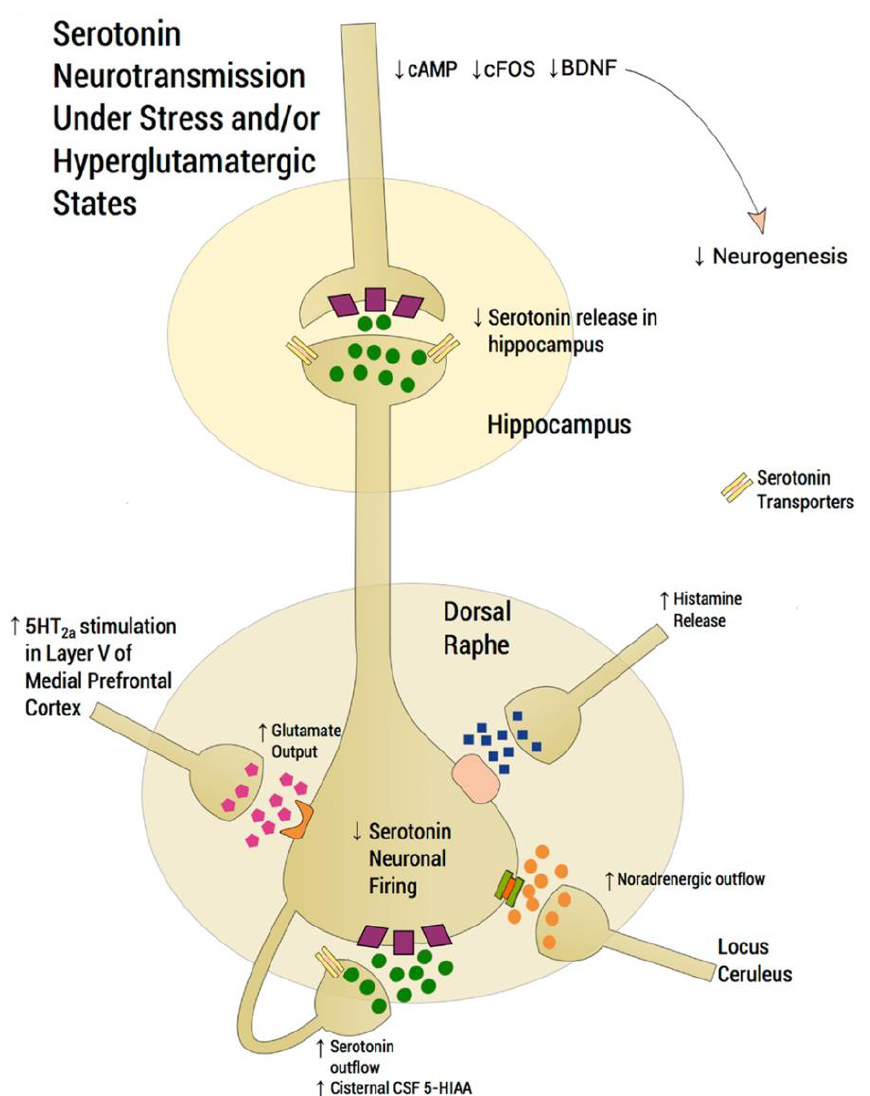
Figure 2. Scheme depicting the functioning of a dorsal raphe nucleus (DRN) serotoninergic neuron under stress conditions that induce depression disorders (modified from [91]). In normal conditions, glutamatergic excitatory afferents from pyramidal neurons of the medial prefrontal cortex (mPFC) directly activate the DRN, thus increasing extracellular serotonin (5-HT), which is regulated by somatodendritic 5-HT 1A autoreceptors, decreasing the excessive release in projection areas such as the mPFC and hippocampus. Under stress conditions, however, glutamatergic neurotransmission is hyperactivated, flooding the DRN with 5-HT (i.e., so-called “5-HT flooding”), but concomitantly attenuating 5-HT outflow. An excessive stimulation of 5-HT 2A Rs in the mPFC increases glutamatergic input, whereas an excessive stimulation of postsynaptic 5-HT 1A Rs in the hippocampus is associated with a deficit at corticolimbic projection sites, thus compromising neuroplastic processes. Based on this scheme, it is possible that SSRIs alleviate depression symptoms through two processes involving nAChRs: (1) inhibiting presynaptic nAChRs at glutamatergic af- ferents, which decreases 5-HT flooding to the DRN, and (2) inhibiting postsynaptic nAChRs, which attenuates DRN activity [7,92–94]. Since noradrenaline (NE) and histamine are also increased during stress/depression conditions, 5-HT neuron firing is inhibited by NE transmission from the locus coeruleus through α2-heteroceptors and by histamine transmission through histamine-1 re- ceptors. Serotonin transporters are located presynaptically. CSF: cerebrospinal fluid; 5-HIAA: 5-hydroxyindoleacetic acid.